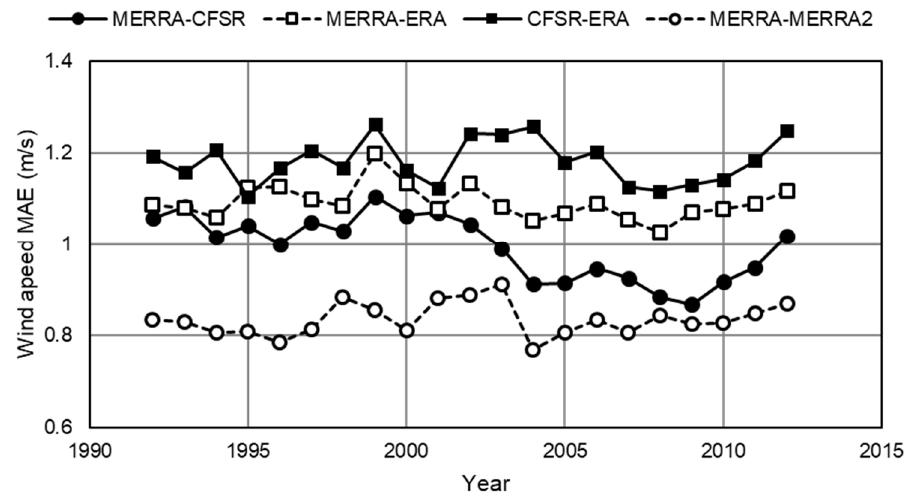
Figure 4. Inter-annual variation of MAEs of wind speed differences between reanalyses.